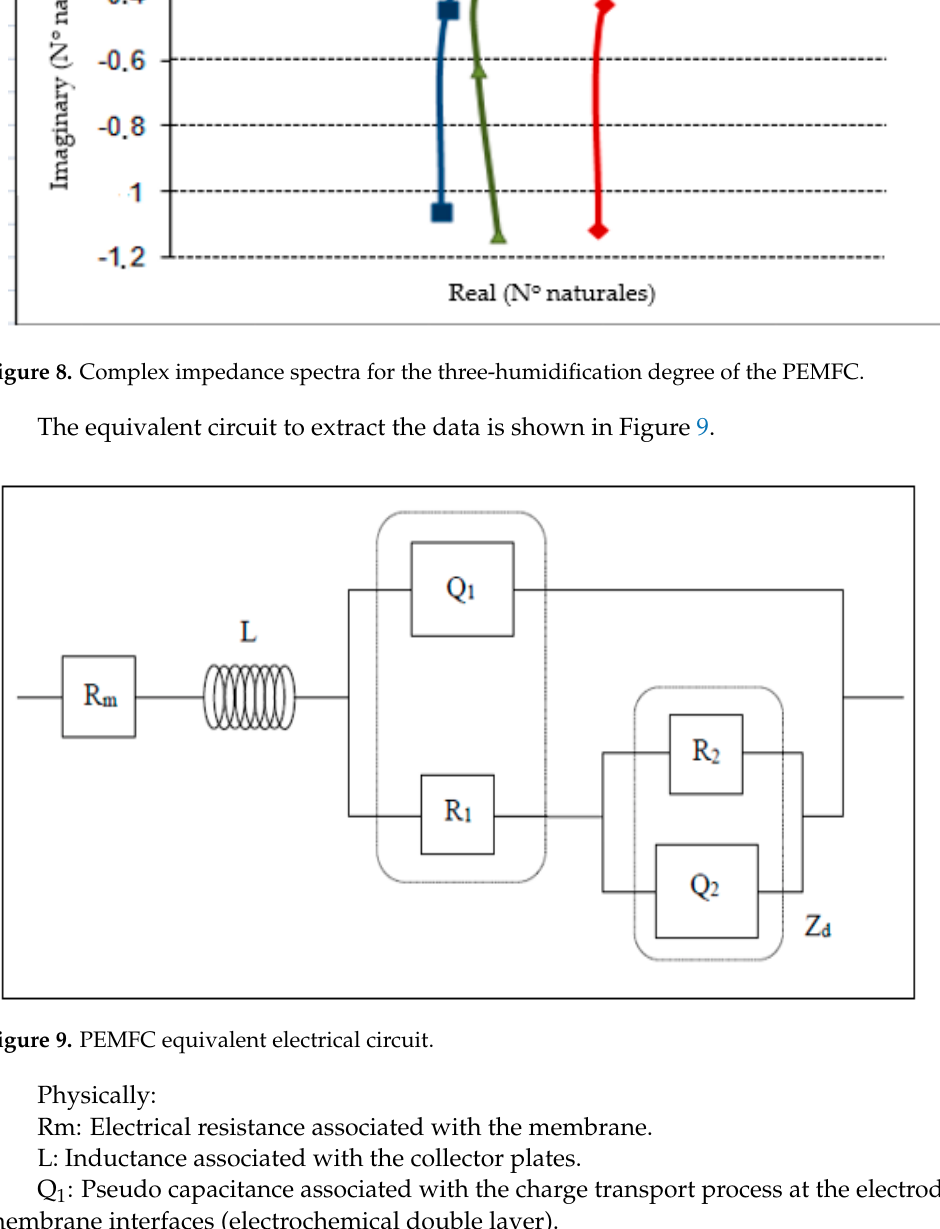
Figure 9. PEMFC equivalent electrical circuit.